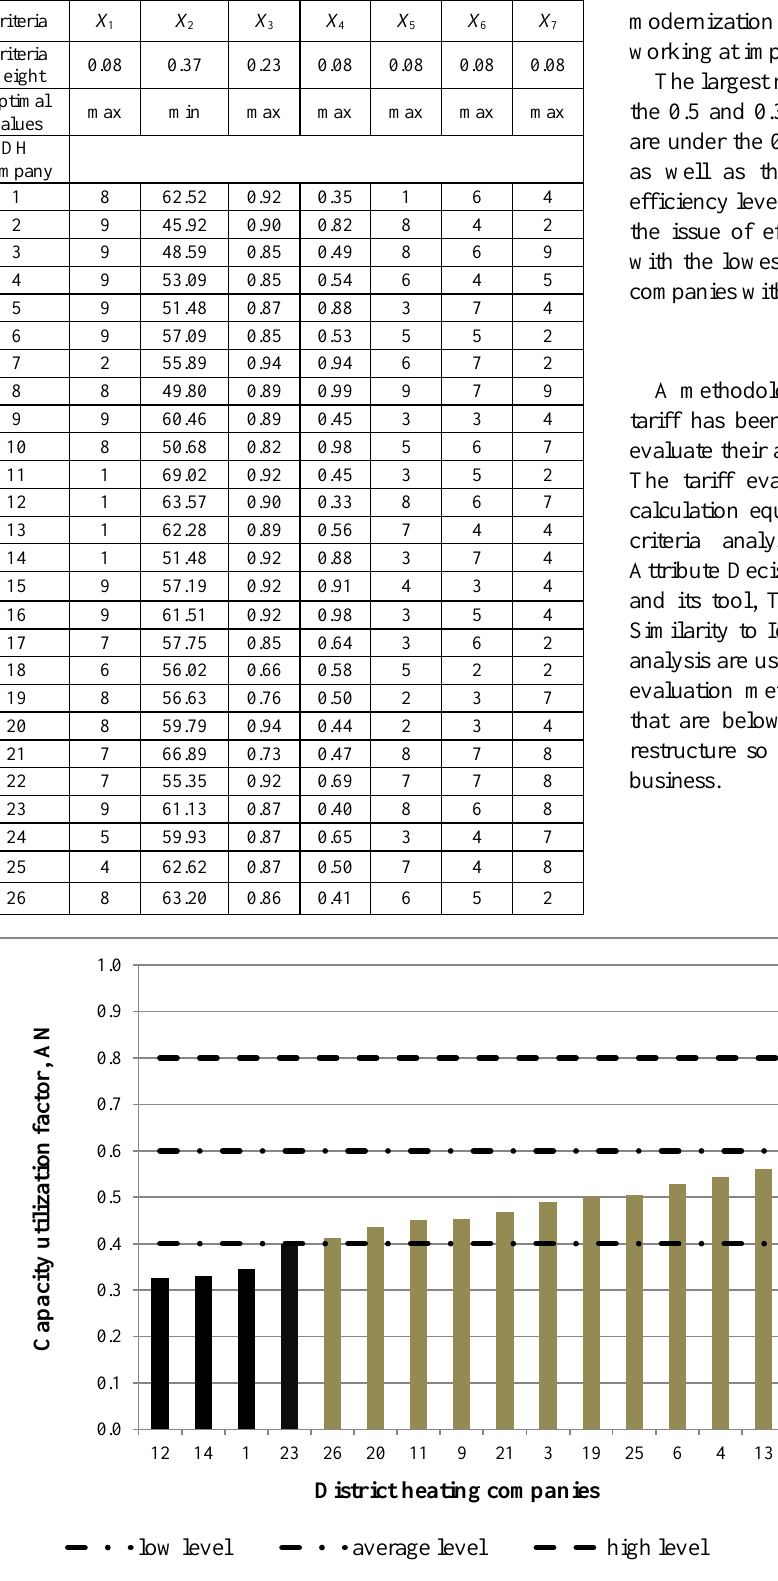
M ATRIX F OR T HE D ETERMINATION OF T HE E NERGY E FFICIENCY OF H EATING C OMPANIES